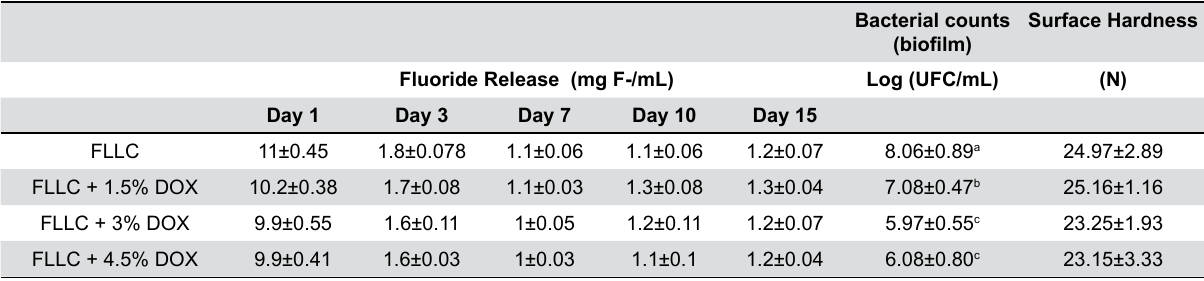
Table 1- Summary and statistical comparisons for all in vitro assays (mean ± SD)